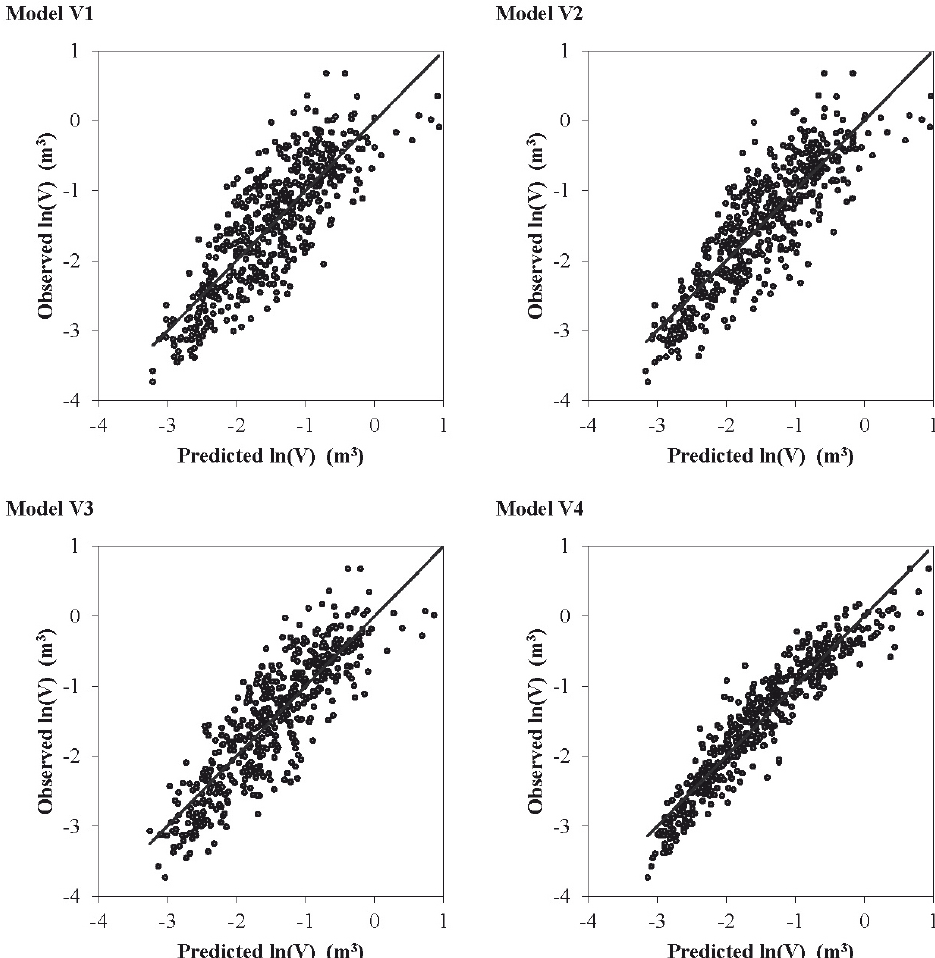
Figure 3. Predicted vs. observed merchantable tree volume (V) for four selected black pine merchantable tree volume models. The solid line represents fitted linear model. Models’ description and evaluation statistic are presented in Table